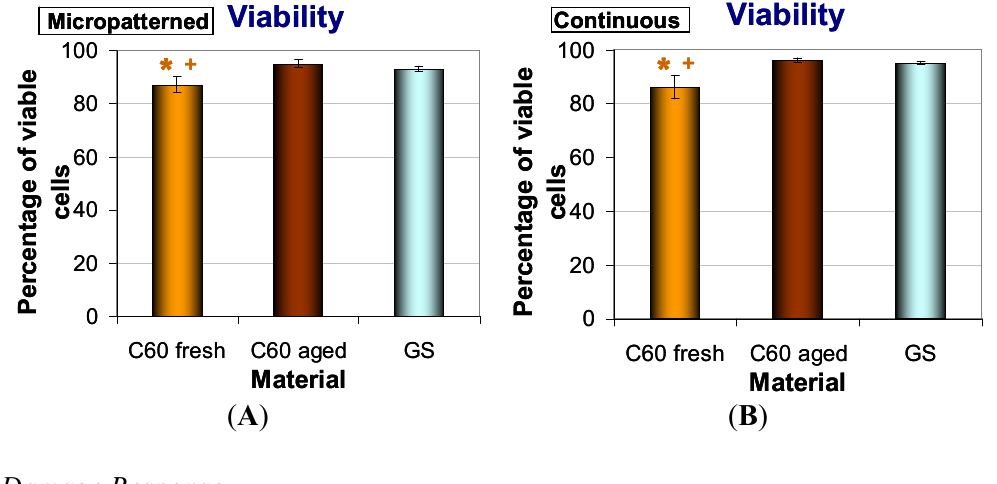
Figure 11. Viability of human osteoblast-like MG-63 cells after seven days of cultivation on micropatterned ( A ) or continuous ( B ) fresh and aged fullerene films. GS, microscopic glass coverslips, reference material; * significant difference to GS; + significant difference aged. p ≤ 0.05 ( * to C 60